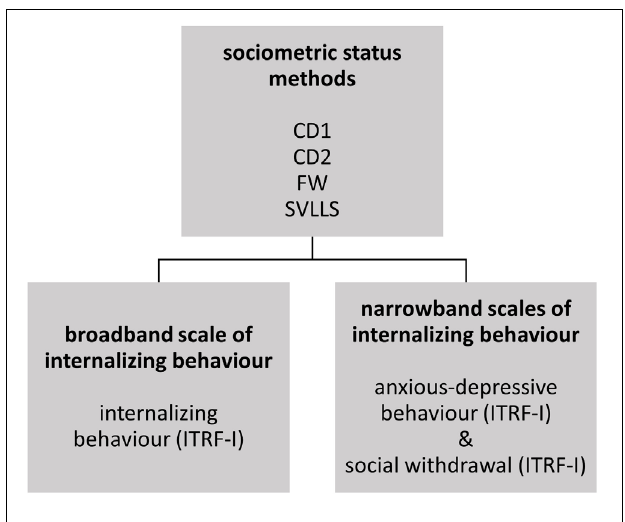
FIGURE 1 | Analysis